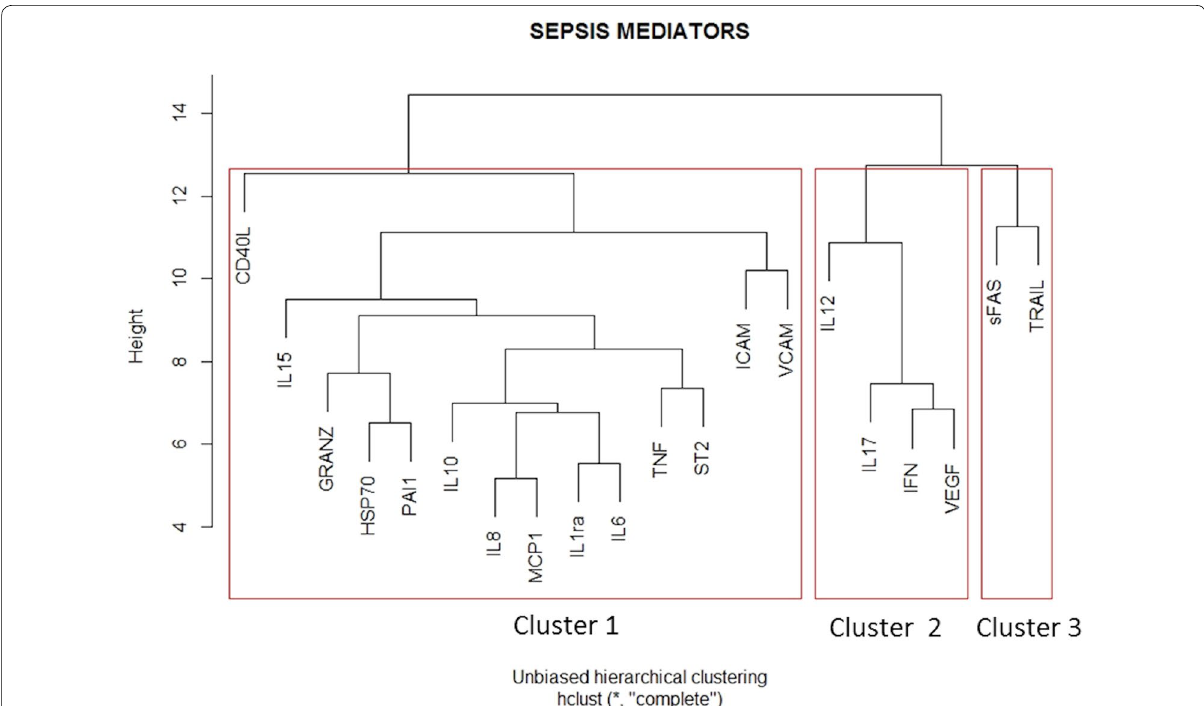
Fig. 1 Hierarchical clustering of all sepsis mediators. The parameters were reordered using computerized hierarchical clustering with the corrplot package of R statistical environment. Hierarchical clustering is a statistical method for finding comparatively homogenous clusters of cases based on measured characteristics. The algorithm uses a set of dissimilarities or distances between cases when constructing the clusters and proceeds iteratively to join the most similar cases. Distances between clusters were recomputed by the Lance–Williams dissimilarity update formula according to the complete linkage